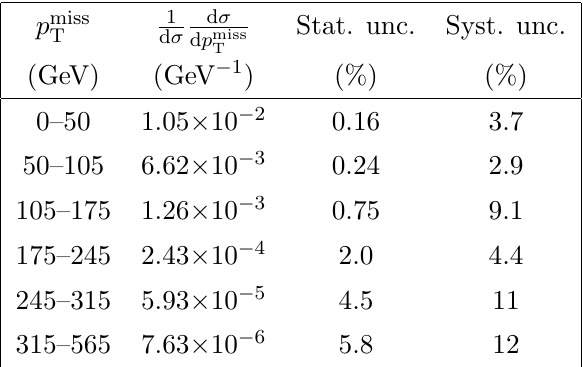
Table 7 . Results of the normalised di(cid:11)erential cross sections with relative uncertainties in the combined channel with respect to p miss